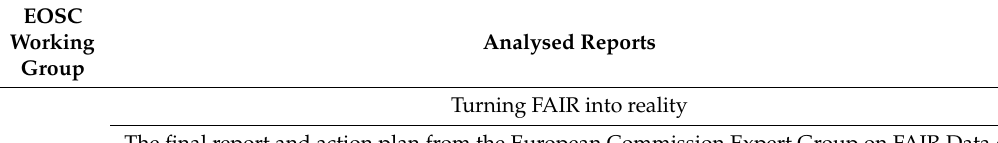
Table 4. Main relevant outputs from the Findable, Accessible, Interoperable and Re-usable (FAIR) and the Architecture European Open Science Cloud (EOSC) Working